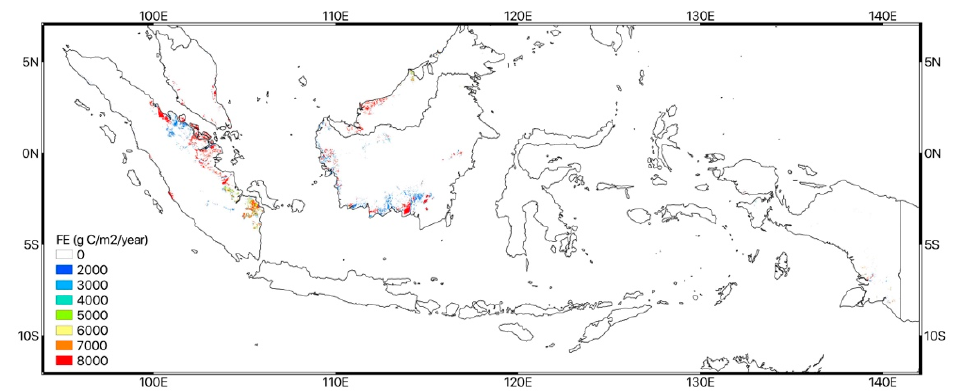
Figure 10. Fire emissions from tropical peatlands in the study region found by using global fire emissions database (GFED) 4.1s data and satellite-based FE data in this study. The monthly averages of GFED and FE were 1.4 and 1.9 Mt C/month with standard deviations of 2.96 and 2.76, respectively. ( a ) Monthly time series and ( b ) a scatter plot of both datasets.